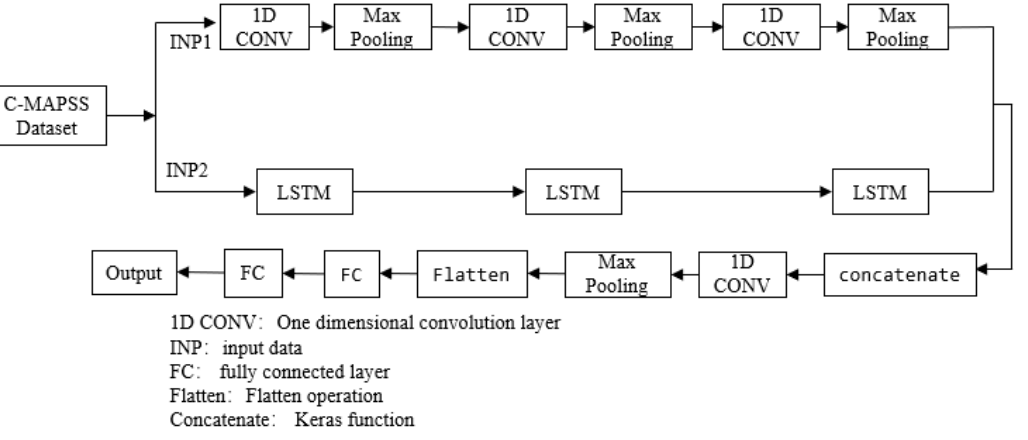
Figure 5. The overall framework of the model.